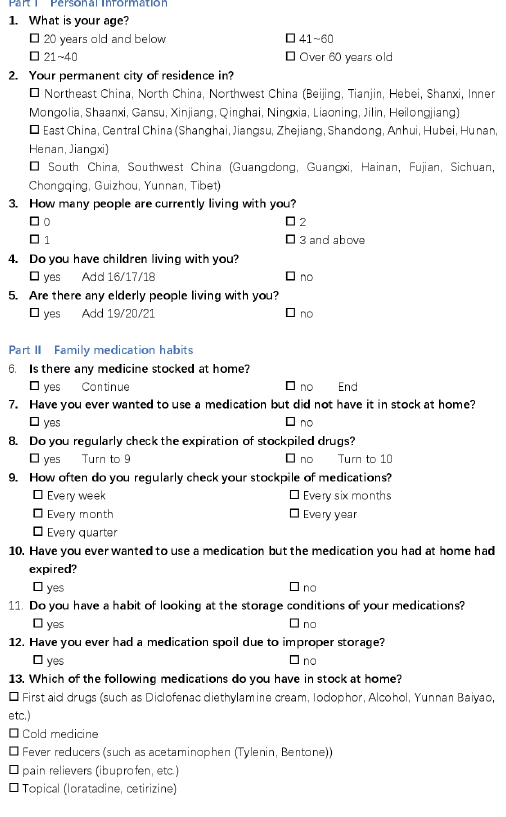
Figure 2. The detail of the questionnaire.